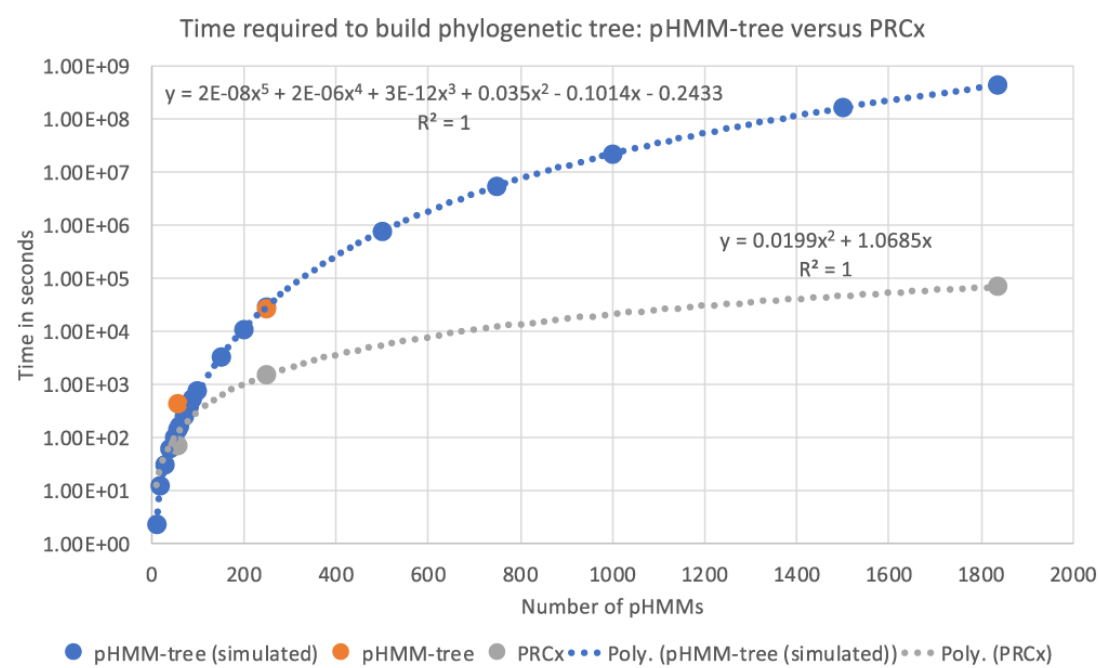
Figure 5. The runtime of pHMM-tree (Huo et al., 2017), both simulated (based on pHMM-tree article in blue) and real (in orange), versus that of PRCx (gray). The X-axis indicates the number of pHMMs in the tree and the Y-axis is the runtime in seconds. For example, building